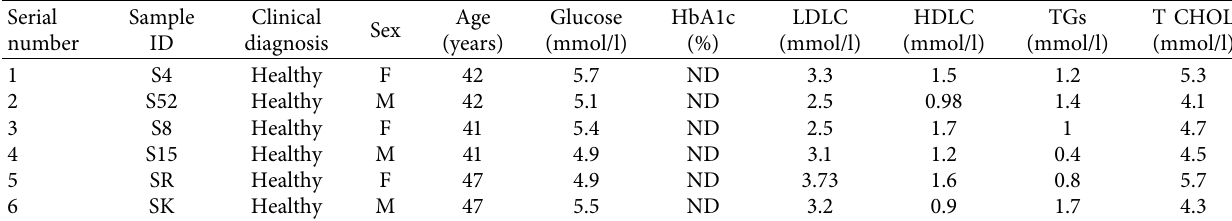
Table 1: Clinical, biochemical, and demographic characteristics of the study